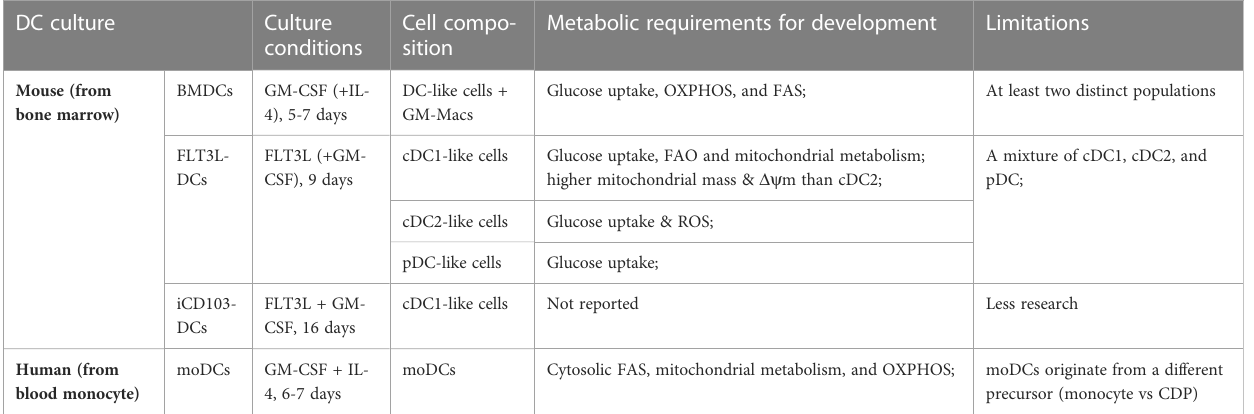
TABLE 1 In vitro models of